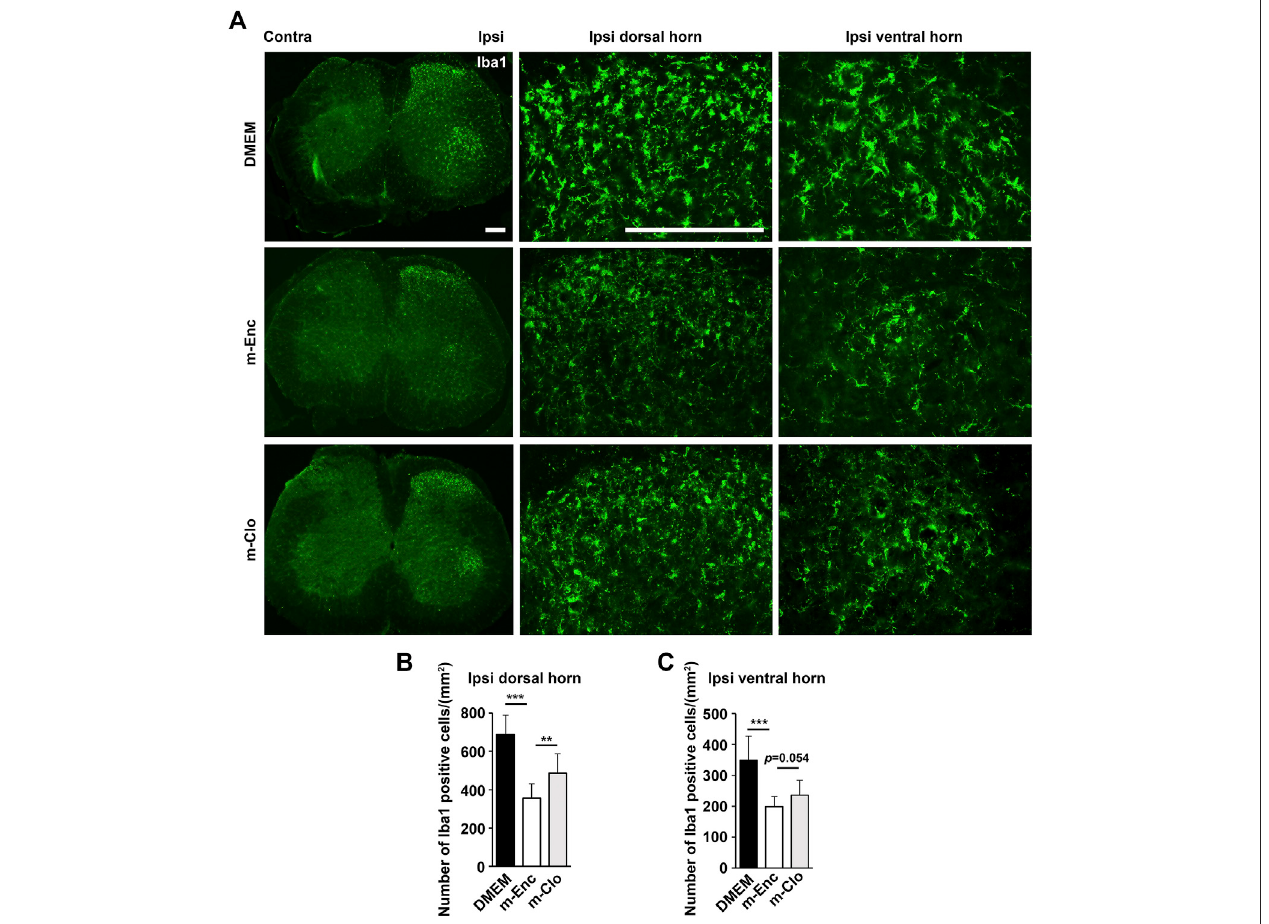
FIGURE 7 | Effects of depletion of SHED-CM-induced M2 on the activation of microglia. (A) Representative images of immuno fl uorescent staining of Iba1 in the ipsilateral dorsal and ventral horn of L3/4 SP 7 days after the PSL. (B,C) Quanti fi cation analysis of Iba1 + cell numbers. Tukey multiple comparisons of means ( n = 8 – 10, per group). Data represent the mean ± SD. ** p < 0.01, *** p < 0.001.